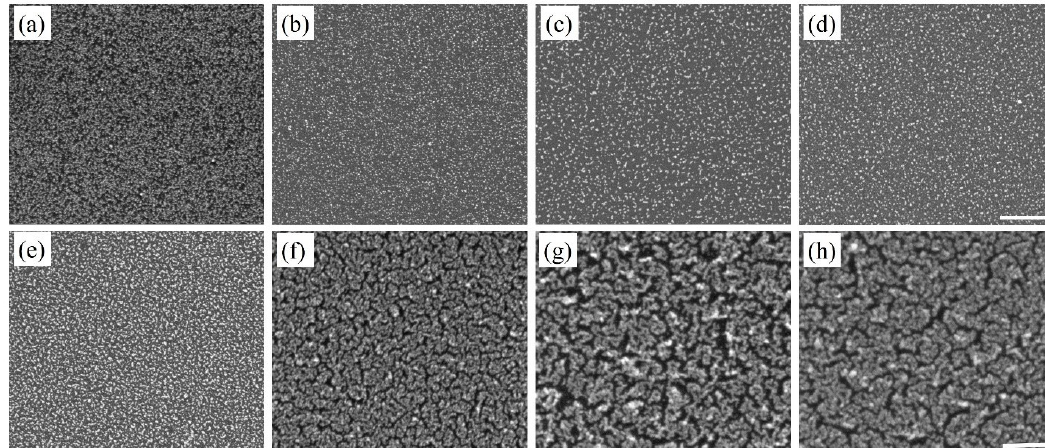
Figure 4. SEM images of Au nanostructures deposited on the Si substrate after ( a ) first, ( b ) second, ( c ) third, ( d ) fourth, ( e ) fifth, ( f ) sixth, ( g ) eighth, and ( h ) tenth deposition cycle with L-Cys added as surfactant. The scale bar is 500 nm.